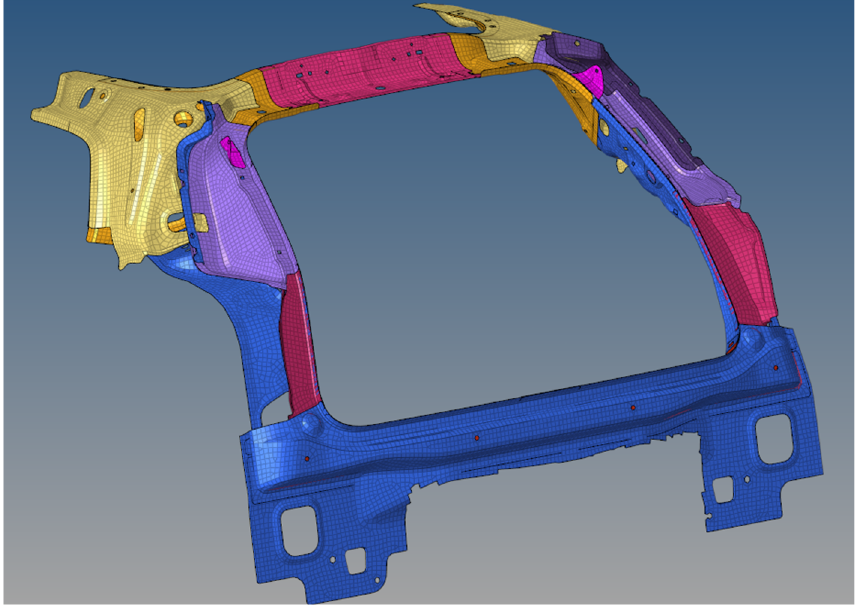
Figure 9. Original rear part (made of steel) of the car body, with highlights of the adopted mesh.